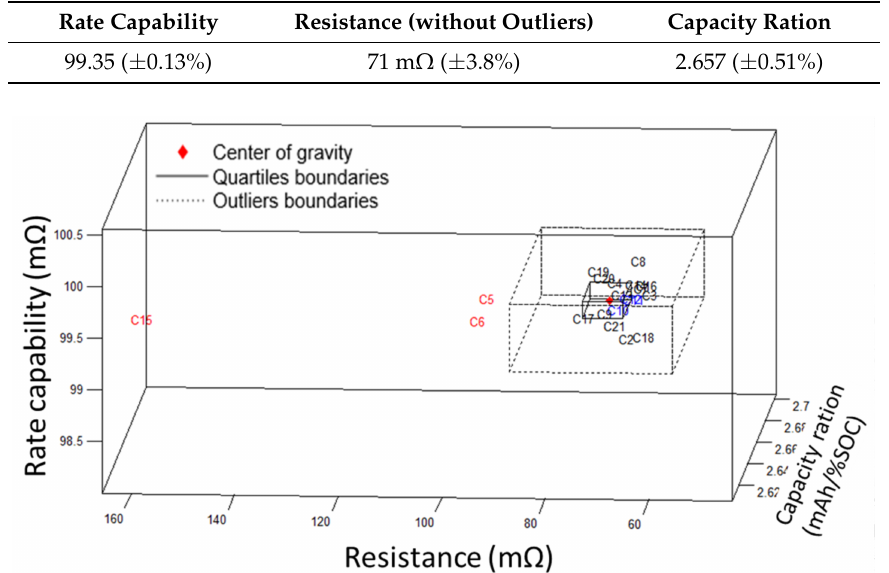
Table 1. Cell-to-cell variation summary.